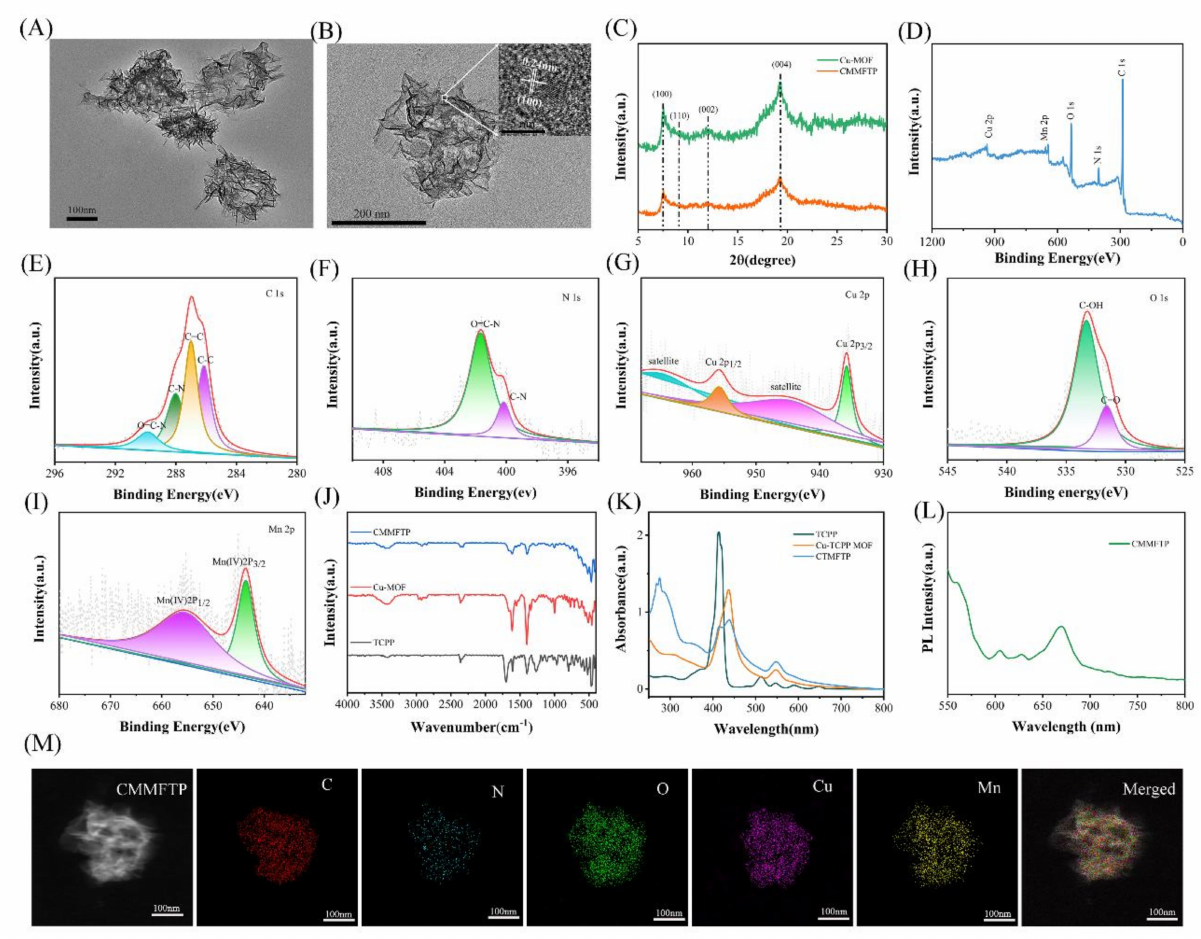
Figure 1. ( A ) Transmission electron microscopy (TEM) image of CMMFTP; ( B ) high-resolution transmission electron microscope (HR-TEM) image of CMMFTP (Inset: HR-TEM image of MnO 2 nanocrystals); ( C ) X-ray diffraction (XRD) patterns of CMMFTP; ( D ) X-ray photoelectron spectroscopy (XPS) spectra of CMMFTP; ( E ) high-resolution X-ray photoelectron spectroscopy (HR-XPS) of C 1s; ( F ) HR-XPS of N 1s; ( G ) HR-XPS of Cu 2p; ( H ) HR-XPS of O 1s; ( I ) HR-XPS of Mn 2p; ( J ) Fourier transform infrared (FT-IR) spectra of TCPP, Cu-MOFs and CMMFTP; ( K ) UV-visible absorption spectra of TCPP, Cu-MOFs and CMMFTP; ( L ) Fluorescence emission spectrum of CMMFTP; ( M ) dark- field TEM image and corresponding elemental mappings images of